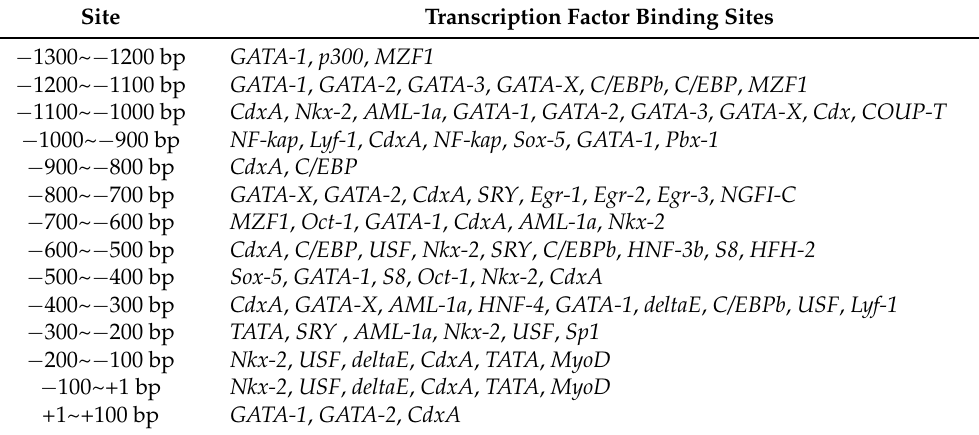
Table 2. The prediction results of transcription factor binding sites of UCP3 gene promoter in Guanling cattle by online software TFSEARCH.